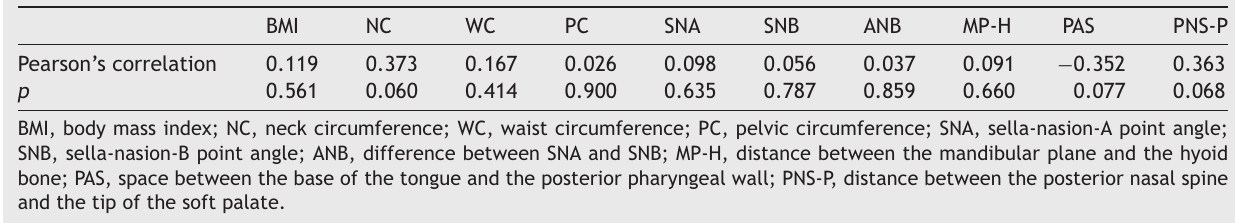
Table 5 Correlation in the age range ≥ 40 and <60 years of anthropometric and cephalometric measurements with AHI ( n = 39). BMI NC WC PC SNA SNB ANB MP-H PAS PNS-P Pearson’s correlation 0.290 0.574 0.492 0.338 − 0.083 0.118 − 0.042 0.380 − 0.021 0.379 p 0.073 0.000 0.001 0.035 0.597 0.473 0.801 0.017 0.900 0.017 BMI, body mass index; NC, neck circumference; WC, waist circumference; PC, pelvic circumference; SNA, sella-nasion-A point angle; SNB, sella-nasion-B point angle; ANB, difference between SNA and SNB; MP-H, distance between the mandibular plane and the hyoid bone; PAS, space between the base of the tongue and the posterior pharyngeal wall; PNS-P, distance between the posterior nasal spine and the tip of the soft palate.